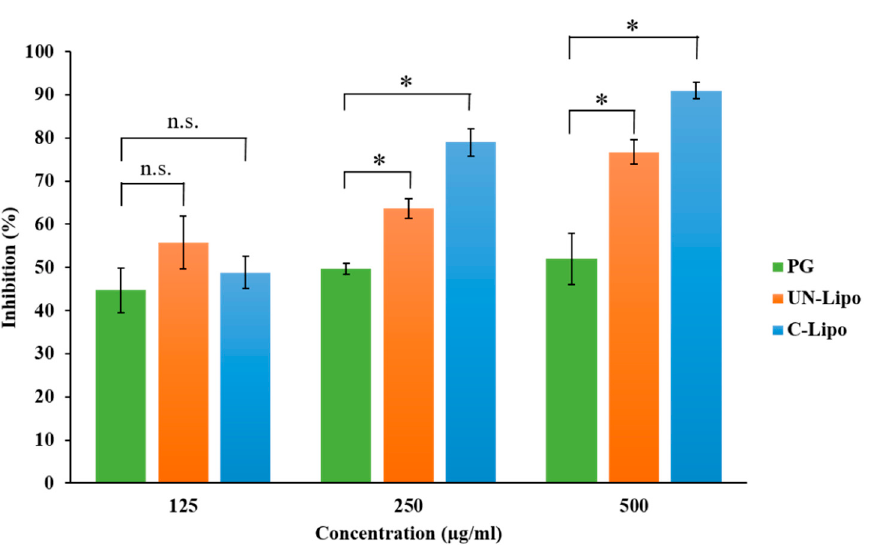
Figure 7. Percentage inhibition of hydrogen-peroxide-scavenging activity of different concentrations of PG-containing coated and uncoated liposomes in comparison to the initial PG solution. Statistical analysis: t-test. * p < 0.05; n.s. means not significant compared to the PG control.